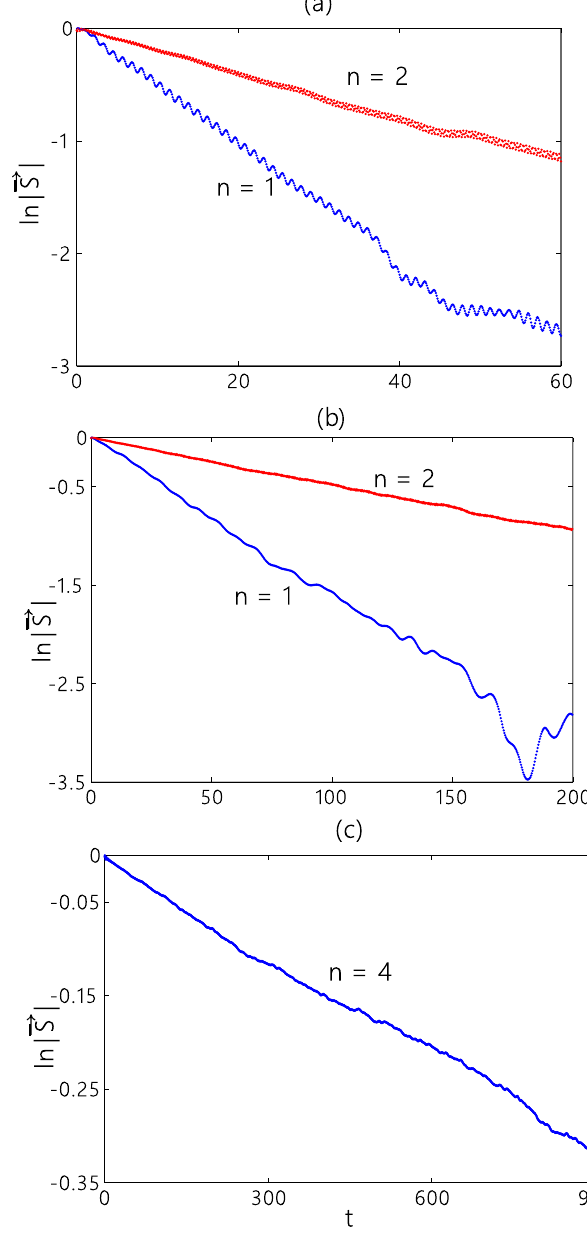
Figure 4. Time evolutions of the logarithm of the length of the pseudo-spin polarization vector for the graph of different sites. The parameters are = J 10 and  = 50 in ( a ) and  = 100 in ( b , c ). The initial states are |1, − 〉 for the graph of three sites ( n = 1), | −〉 + | −〉 ( 2, 1, )/ 2 for the graph of five sites ( n = 2), and | 〉 + | 〉 − + k k (1) (1) for the graph of 9 sites ( n =